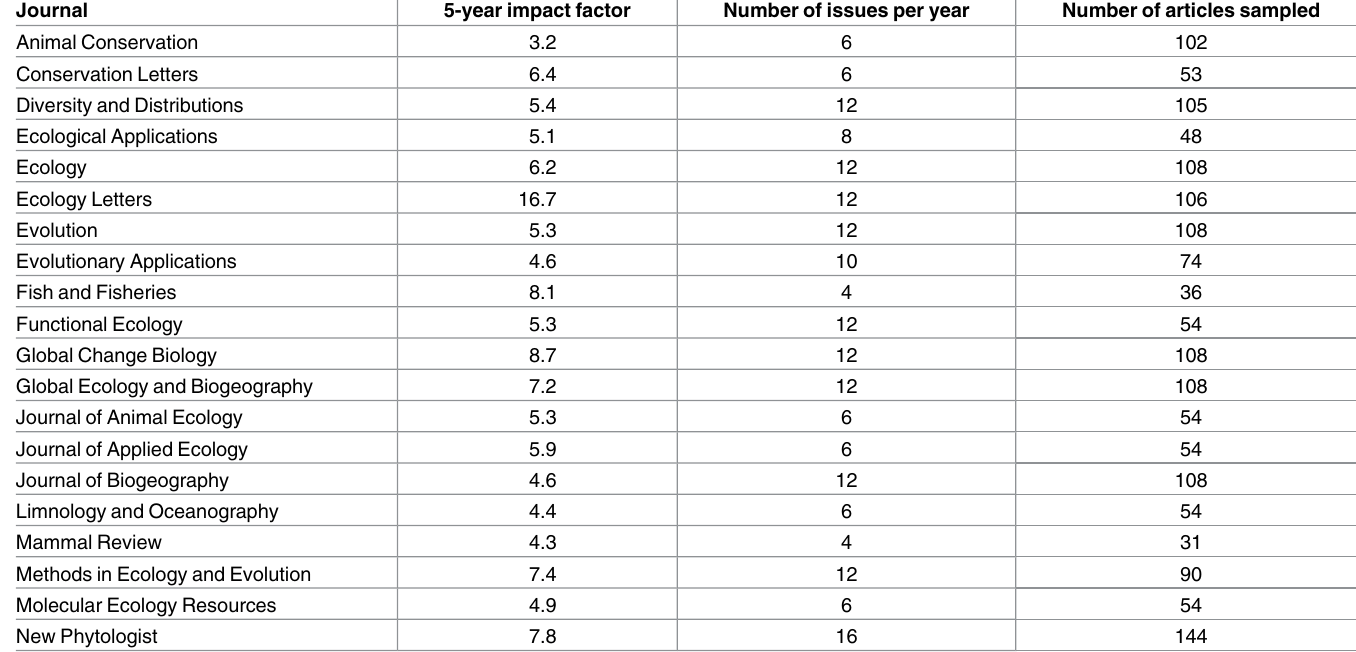
Table 2. Impact factors, number of issues per year, and number of articles sampled from twenty ecological